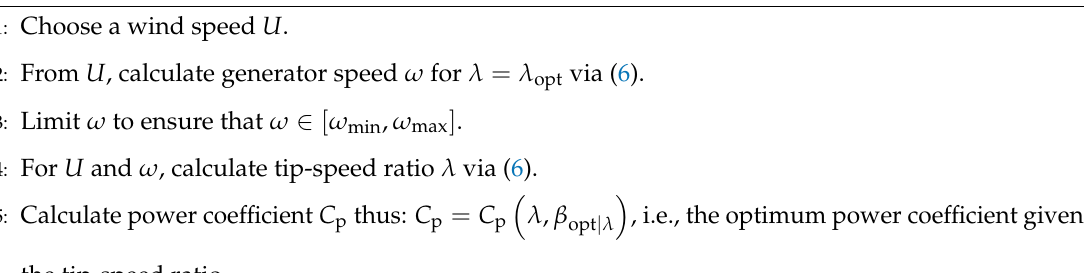
Algorithm 8 Calculate the β δ look-up